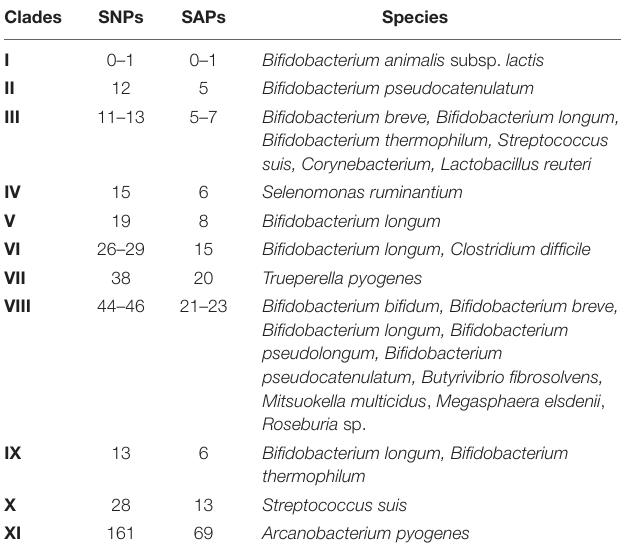
TABLE 2 | Clades in the nucleotide and protein phylogenetic trees based on number of SNPs and SAPs. Clades SNPs